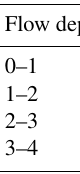
Table 3. Numeric values assigned to the Ex parameter.